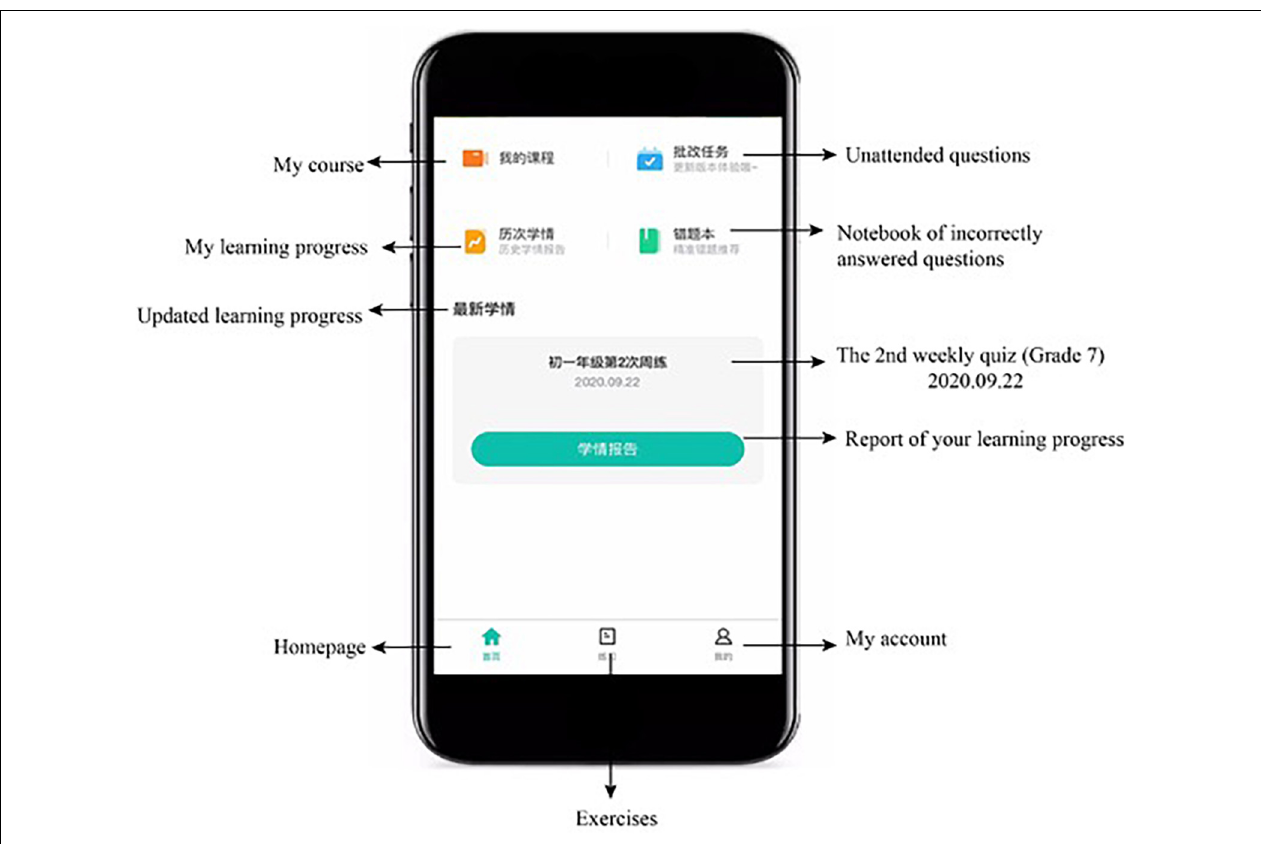
FIGURE 2 | User interface of setting goals and monitoring